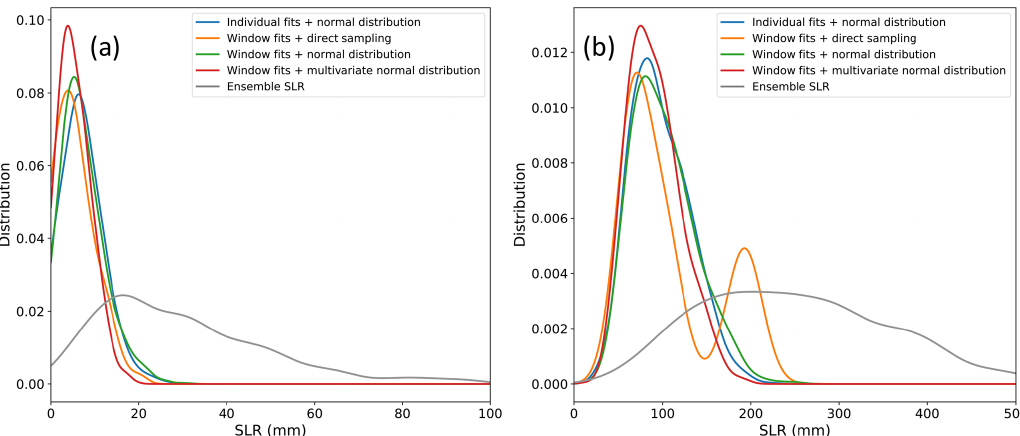
Figure 11. Sea level rise probability distributions for (a) year 100 and (b) year 200. The ensemble SLR PDF at year 100 and 200 (grey), and the predicted SLR PDFs for three prior methodologies described: (1) individual fits + normal distribution (blue), (2) window fits + direct sampling (orange), (3a) window fits + normal distribution (green), and (3b) window fits + multivariate normal distribution